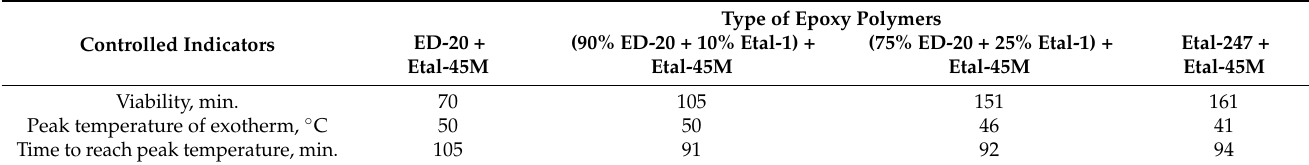
Table 2. Indicators of viability and exothermicity of epoxy